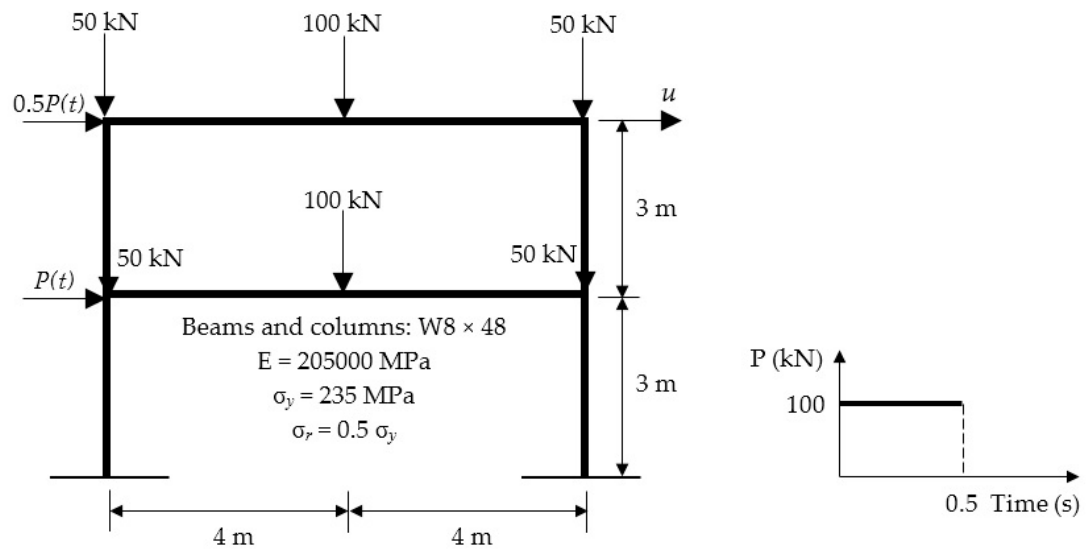
Figure 14. A two-storey steel frame under dynamic loading [15].